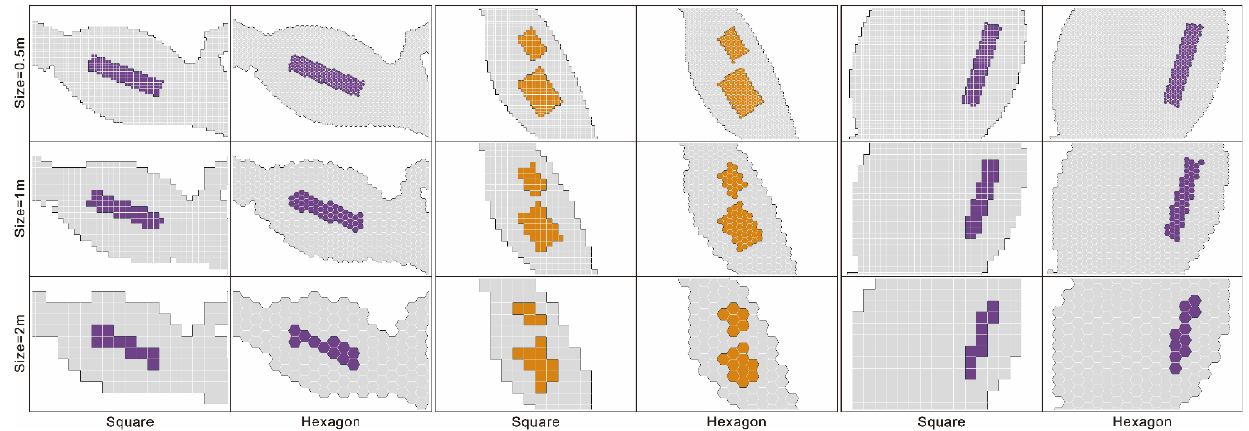
Figure 13. Detailed renderings of the areas with four obstacles (20005, 20006, 20007, 20008). However, when the size is large, the grid may still have some differences in describing the real scene. This difference is manifested in the delayed arrival of inaccurate descriptions due to the larger density of the hexagonal grid. For example, the T -shaped subchannel region (Figure 14) in the middle of the channel region (10001) is clearly not accurately described by the quadrilateral grid, resulting in the formation of two disconnected subregions, but is accurately described by the hexagonal grid.